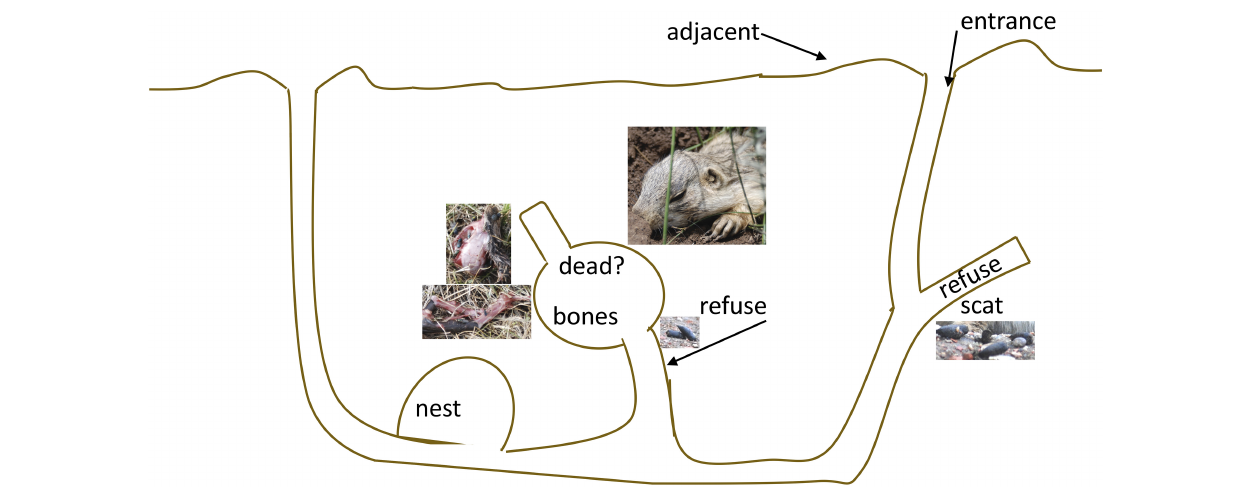
FIGURE 1 | Schematic of the regions of a prairie dog burrow (not to scale), designed after Wilcomb (1954), showing chambers used for various purposes including nesting, defecating, and isolating dead individuals.